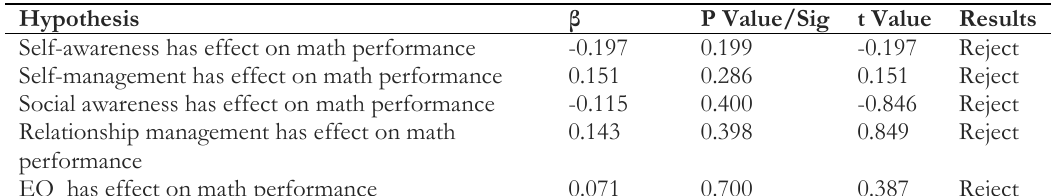
Table 6. Test of hypothesis.